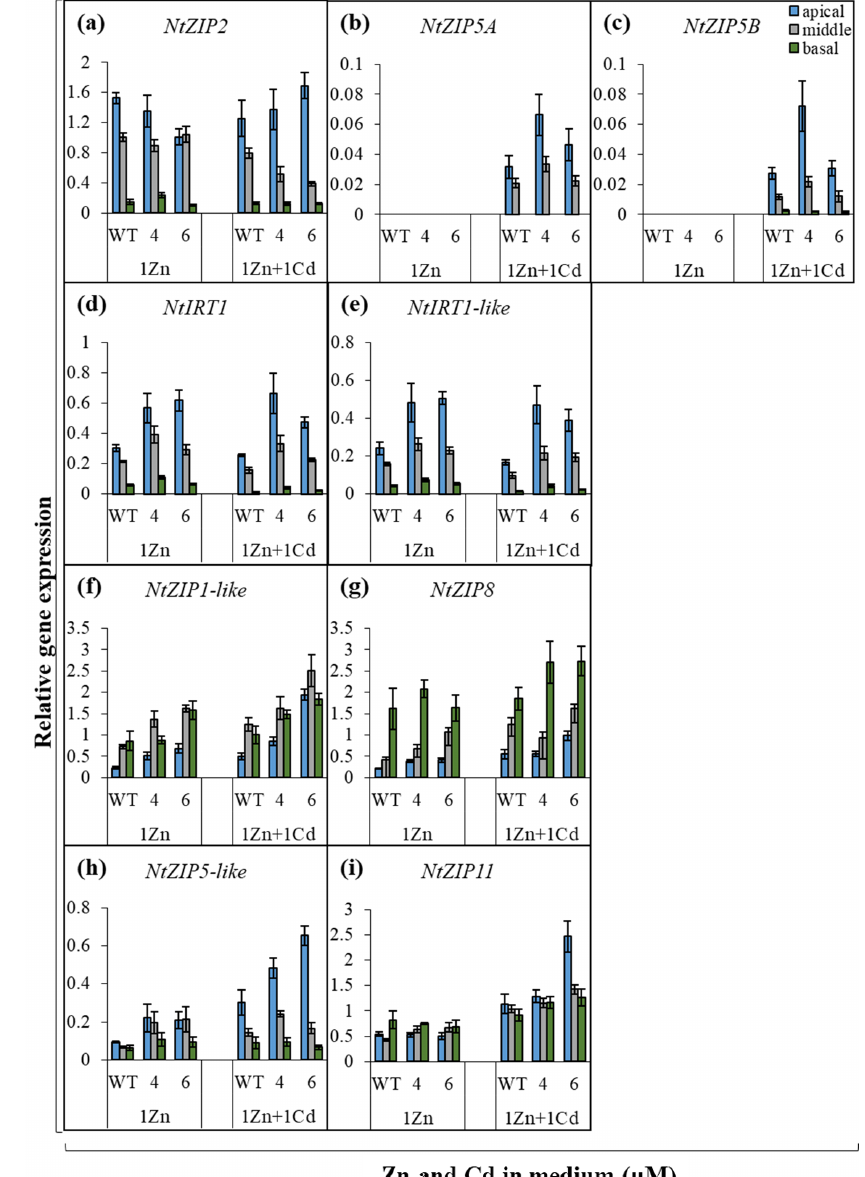
Figure 8. Expression of tobacco ZIP genes in the apical, middle, and basal parts of wild-type and NtZIP4A / B -RNAi plants grown at 1 µ M Zn with or without 1 µ M Cd. 3.5-week-old plants of wild-type (WT) and NtZIP4A / B -RNAi lines (number 4, number 6) grown in the quarter-strength Knop’s medium were exposed for 17 days to the control medium supplemented with 1 µ M Zn with or without 1 µ M Cd. Expression of NtZIP2 ( a ), NtZIP5A ( b ), NtZIP5B ( c ), NtIRT1 ( d ), NtIRT1-like ( e ), NtZIP1-like ( f ), NtZIP8 ( g ), NtZIP5-like ( h ), and NtZIP11 ( i ). Gene expression was normalized to the PP2A level. Values correspond to arithmetic means ± SD ( n = 3); those with a ratio greater than 2 are considered significantly different